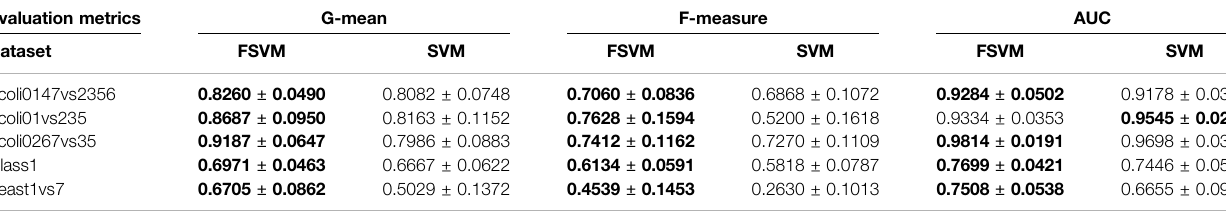
TABLE 4 | Classi fi cation effect of DFSVM under two different base classi fi ers.